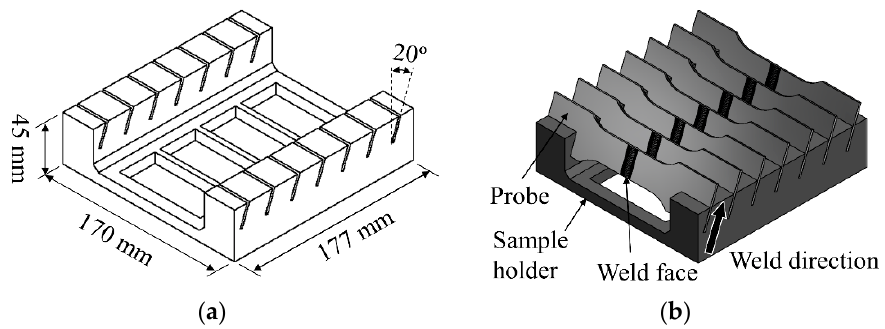
Figure 7. ( a ) Specimen holder geometry and ( b ) configuration of the specimens during the corrosion tests.